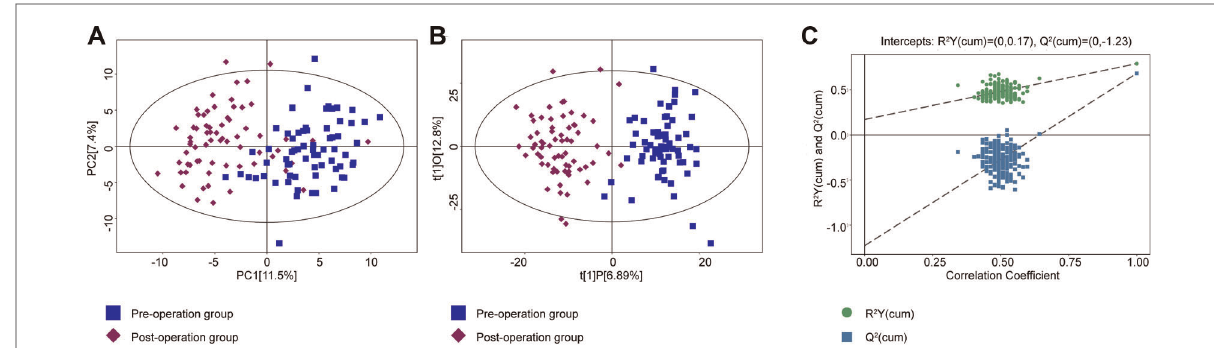
FIGURE 1 ( A ) PCAwas conducted between the preoperation group (blue dots) and postoperation group (purple dots). ( B ) The OPLS-DA model was constructed using data from 67 CRC patients ’ serum metabonomics before (blue) and after (purple) surgery. ( C ) The permutation test plot of OPLS-DA (green, the value of R 2 Y ; blue, the value of Q 2 ; permutation test with 200 times, a p value of CV-ANOVA<0.01). PCA, principal component analysis; OPLS-DA, orthogonal projections to latent structures-discriminant analysis; CRC, colorectal